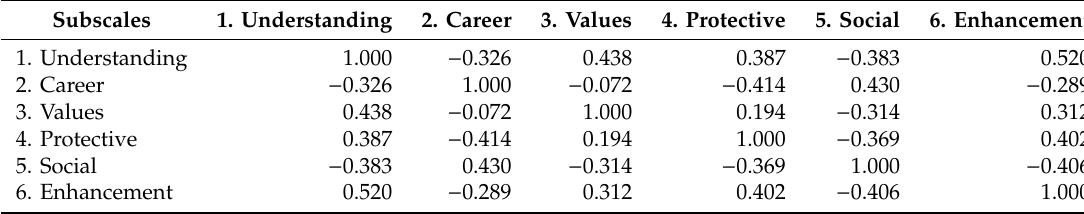
Table 5. Factor correlation matrix (6 factors, 27